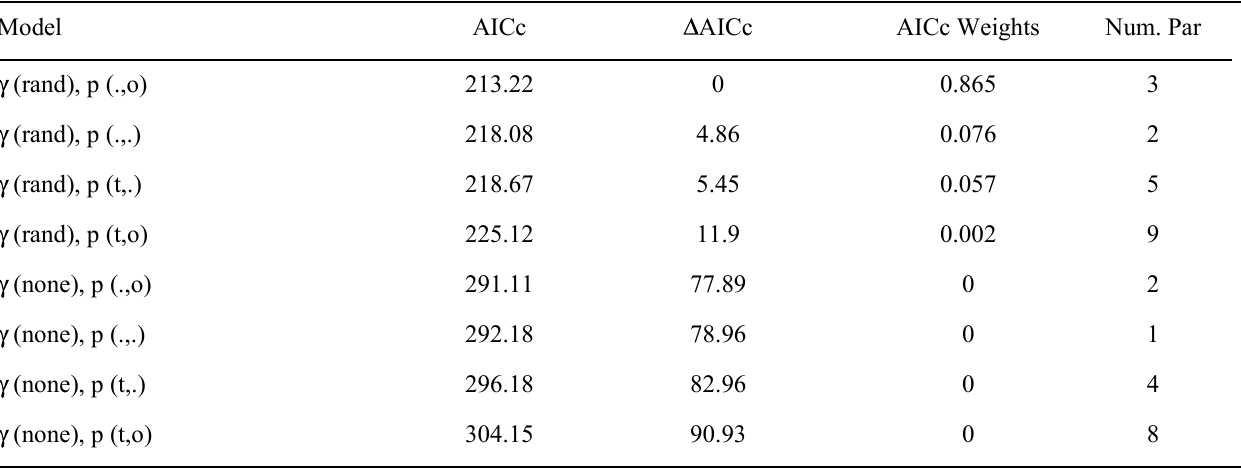
Table 1. Model selection for the Hooded Warbler using the AIC Criteria. The model set includes temporary emigration process being none or random. Conditional detection probability is interval varying (t), observer varying (o), and or constant